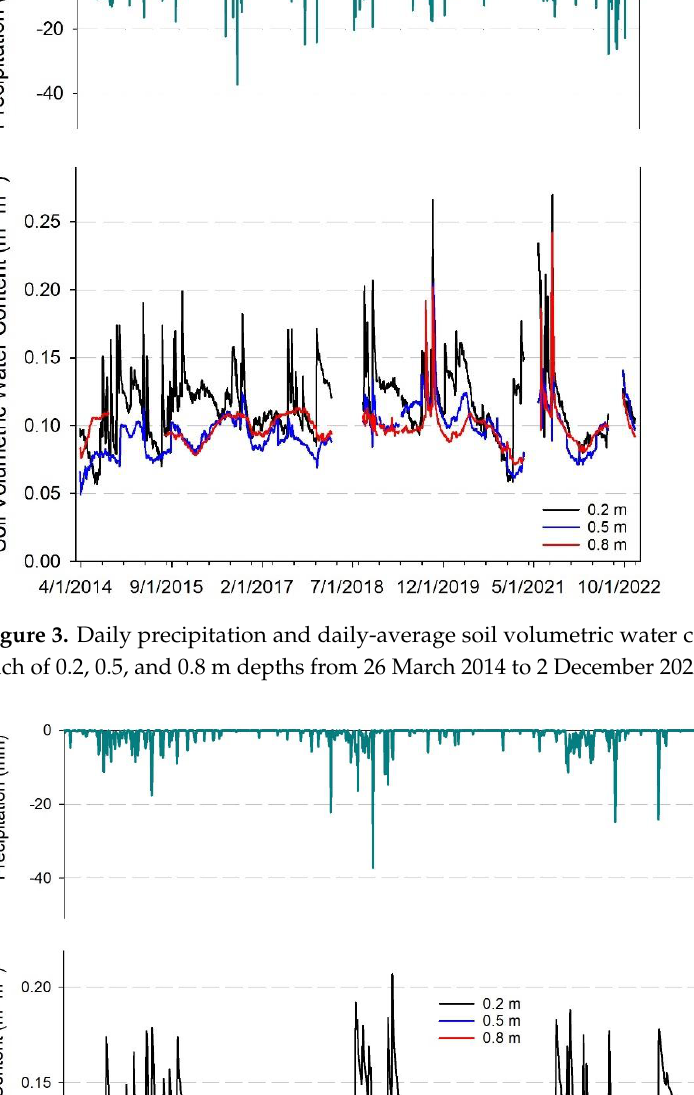
for the 0.5 m sensor. The higher θ levels observed at 0.8 m than at 0.5 m were attributed to finer-textured soil, which consequently increased water holding capacity, noted at that depth during sensor installation.